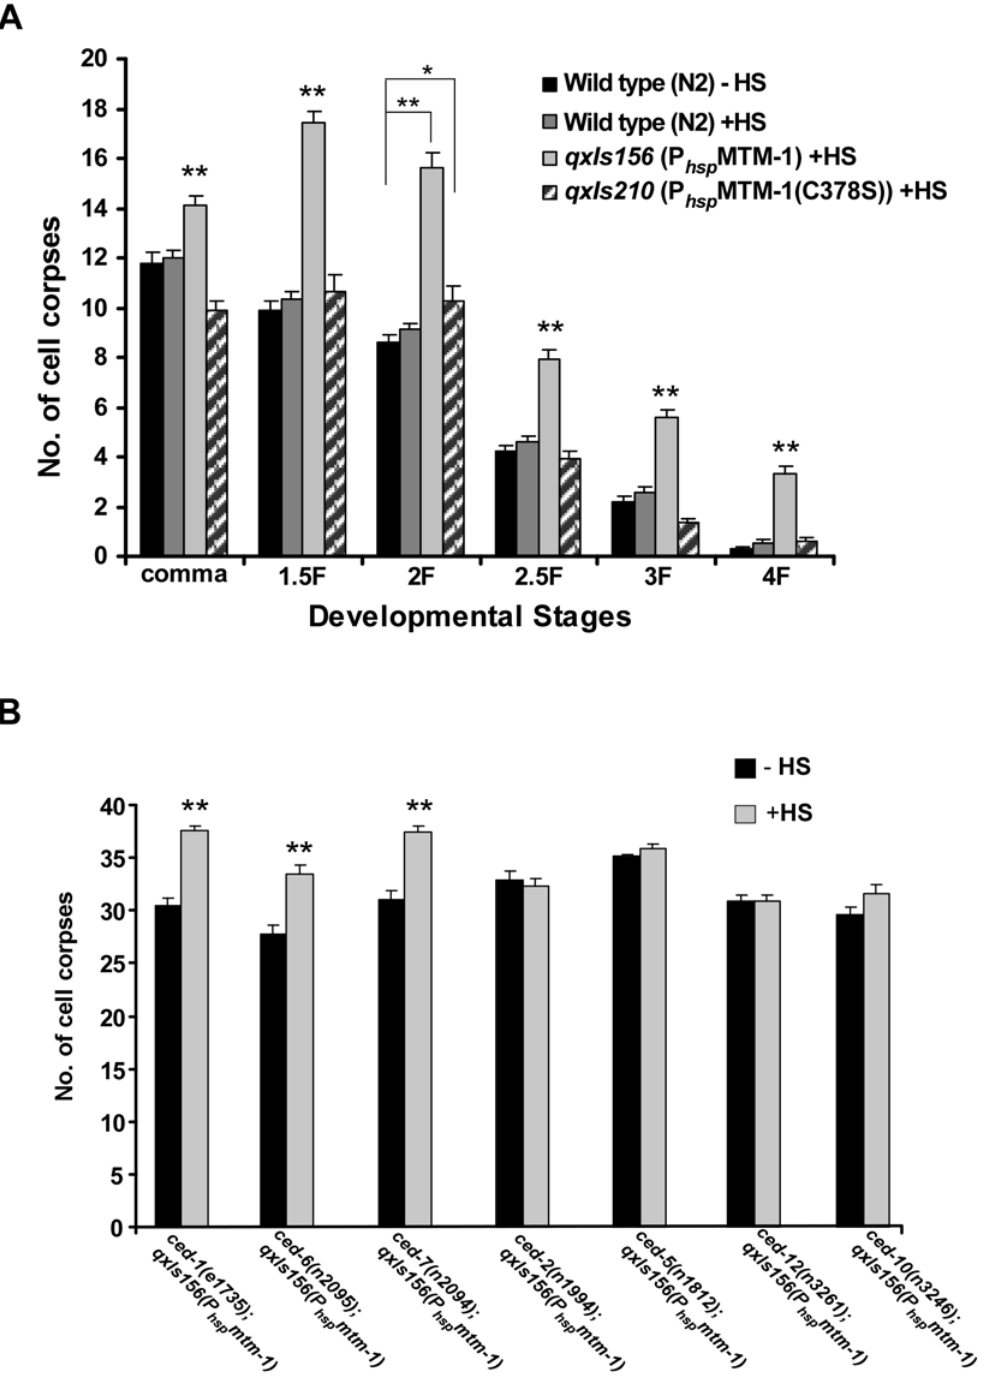
Figure 1. Overexpression of MTM-1 results in accumulation of cell corpses. (A) Time-course analysis was performed in wild type (no heat- shock treatment: black; after heat-shock treatment: gray), qxIs156 (P hsp MTM-1; light gray) and qxIs210 (P hsp MTM-1(C378S); hatching). Cell corpses were scored at the following embryonic stages: bean/comma (comma), 1.5-fold (1.5F), 2-fold (2F), 2.5-fold (2.5F), 3-fold (3F) and 4-fold (4F). At least 15 embryos were scored at every stage; error bars indicate s.e.m. Data derived from wild type with and without heat-shock treatment, wild type and qxIs156 or wild type and qxIs210 at multiple developmental stages were compared by two-way analysis of variance. Post-hoc comparisons were done by Fisher’s PLSD (protected least squares difference). * P , 0.05, ** P , 0.0001. All other points had P values . 0.05. (B) Cell corpses in the indicated strains were scored at the 4-fold embryonic stage. At least 15 embryos were scored; error bars indicate s.e.m. Data were compared by unpaired t tests. ** P , 0.0001; other points had P value . 0.05. In (A) and (B), heat-shock experiments were performed as described in Materials and Methods.